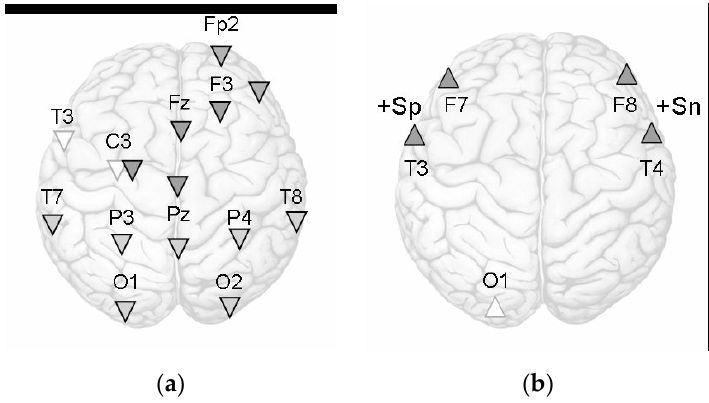
Figure 1. Emotion-induced changes in the alpha1 ( a ) and beta2 ( b ) oscillations. Note: Triangles down indicate a decrease of the alpha1power, triangles upward indicate the beta2 rhythm increase as compared to the rest (Sr): light triangles for Sn, dark triangles for Sp, light gray—common changes for both Sp and Sn; + Sp, + Sn indicate significant correlation between the beta2 power and self-assessment of emotion